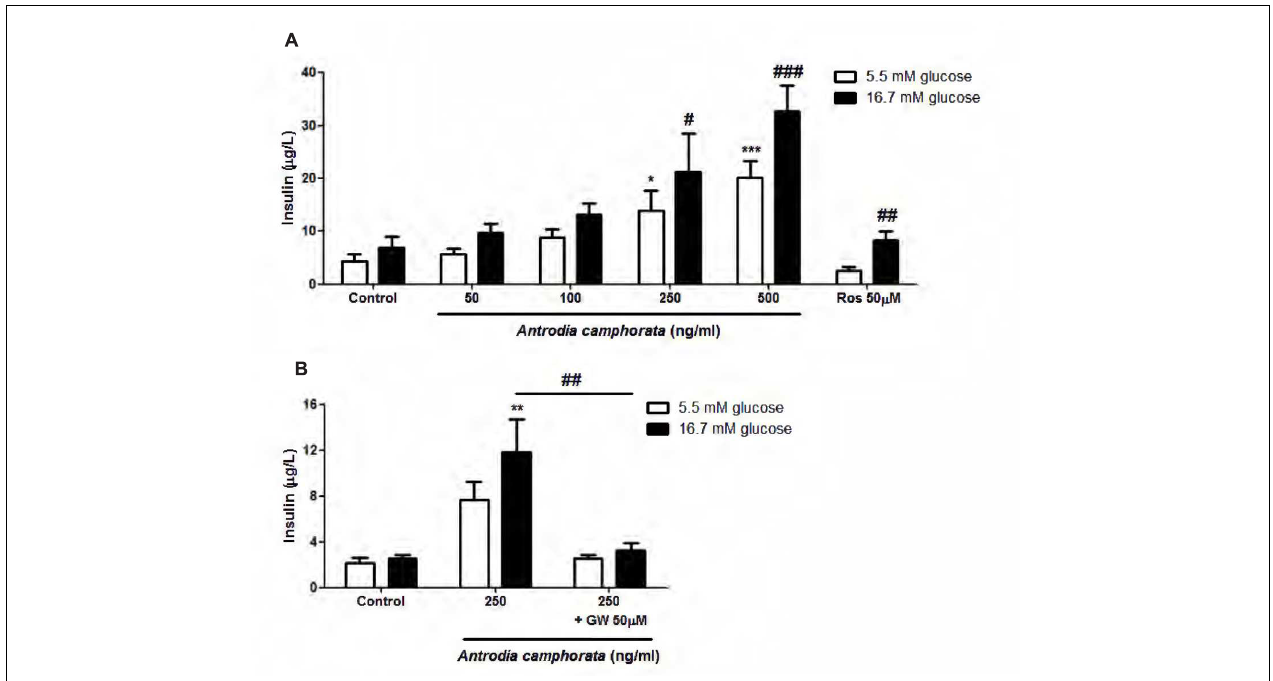
FIGURE 1 | Antrodia camphorata increased insulin secretion through PPAR- γ in MIN6 cells. The cells were treated with A. camphorata for 24 h, and were stimulated with Krebs–Ringer bicarbonate buffer (KRBB) 5.5 mM or 16.7 mM glucose for 1 h. (A) Insulin levels were determined using a mouse insulin ELISA kit. 50 µ M Rosglitazone (Ros), a PPAR- γ agonist, was used as a positive control, n = 4–6. One-way ANOVA; ∗ P < 0.05, ∗∗∗ P < 0.001 vs. control with KRBB 5.5 mM glucose; # P < 0.05, ## P < 0.01, ### P < 0.001 vs. control with KRBB 16.7 mM glucose. (B) The cells were treated with 250 ng/ml A. camphorata in the absence and presence of 50 µ M GW9662 (GW), PPAR- γ inhibitor, n = 5. ∗∗ P < 0.01 vs. control with KRBB 16.7 mM glucose; ## P < 0.01. Results were expressed as mean ±